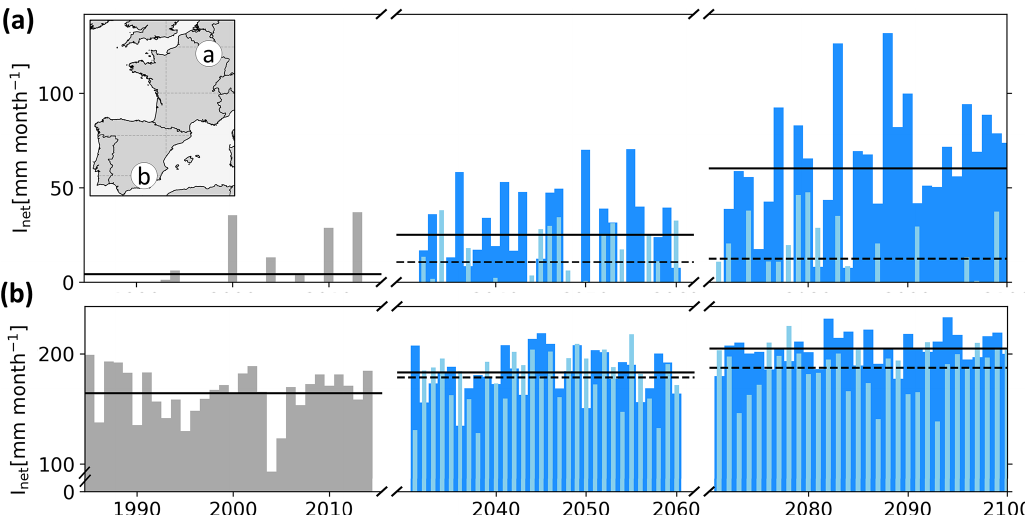
Figure 9. Time series of summer I net (mm per month) simulated with climate data extracted from IPSL-CM6A-LR for two locations, (a) 49.75 ◦ N, 5.25 ◦ E and (b) 38.25 ◦ N, 2.75 ◦ W, marked in the inset. SSP1–2.6 is represented by thin light blue bars and SSP5–8.5 by dark blue wider bars. The horizontal lines correspond to the time series mean over the climate window; for the future horizons, the dotted lines correspond to SSP1–2.6 and the full lines to